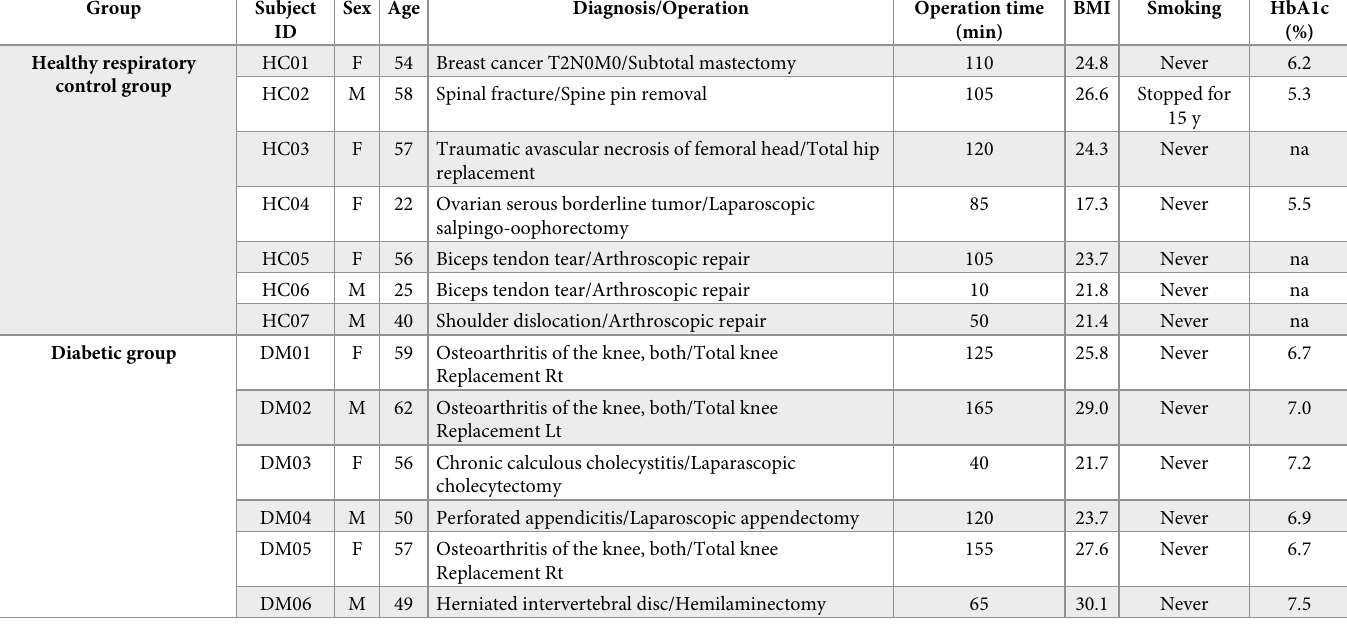
Table 1. Subject clinical information.